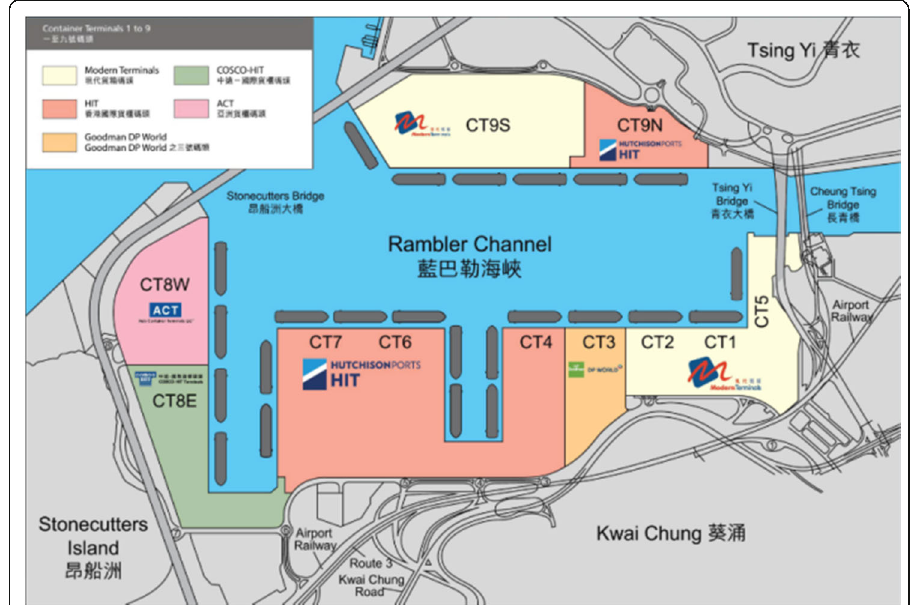
Fig. 1 Hong Kong Container Terminal Operators Association,